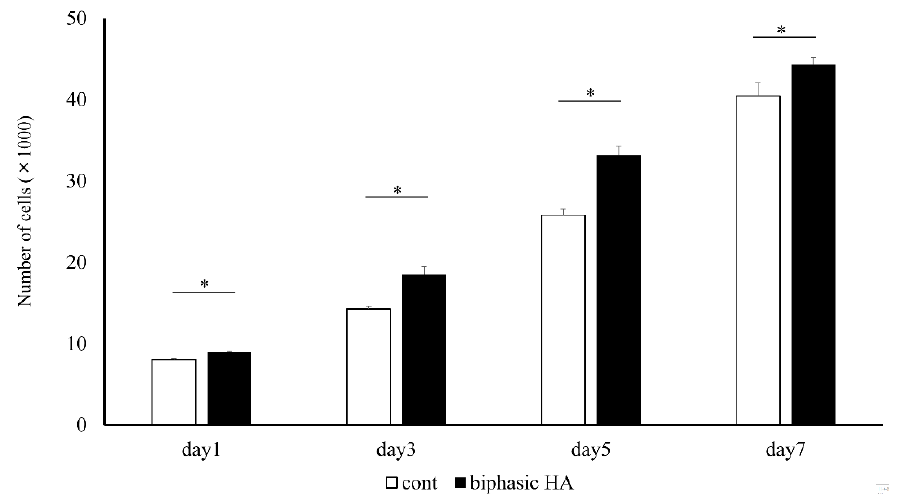
Figure 8. Cell proliferation ability of HA granules and biphasic HA granules (n = 4, * p < 0.05).